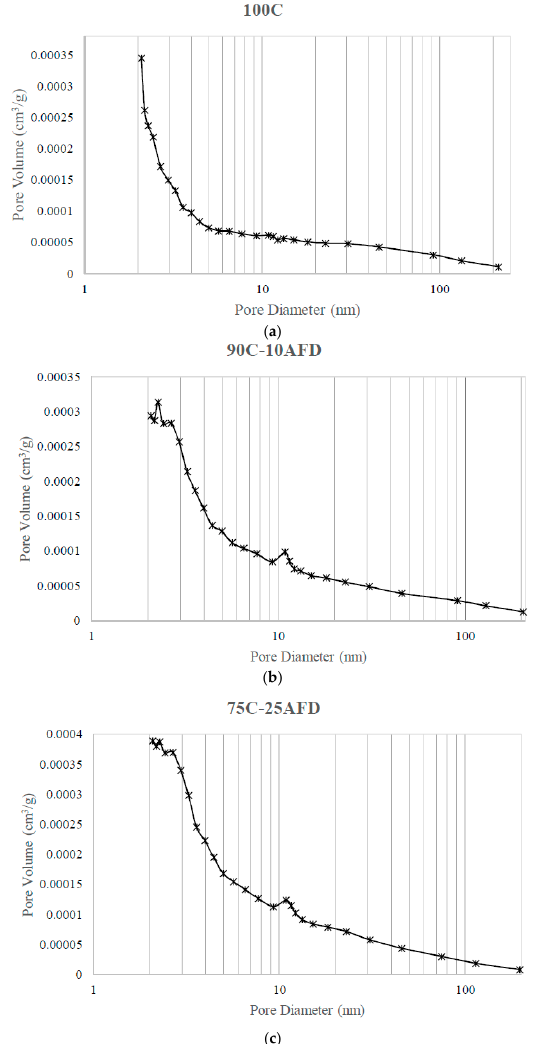
Figure 6. Pore size distribution determined from adsorption data using the BJH method for samples ( a ) 100C, ( b ) 90C-10AFD, and ( c ) 75C-25AFD.